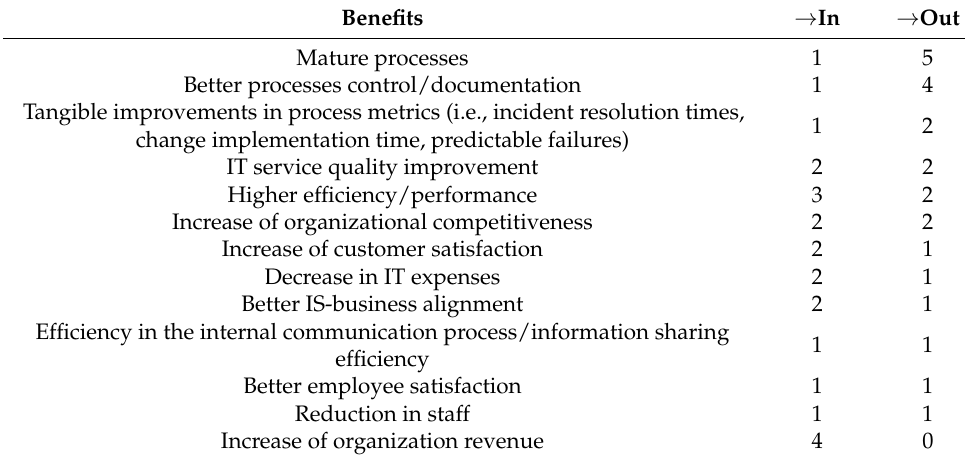
Table 6. Relation between Benefits and